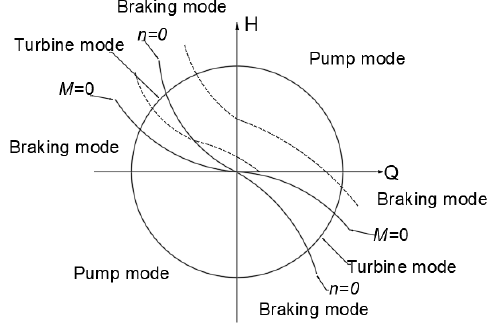
Figure 7. Four-quadrant operation characteristic curve.